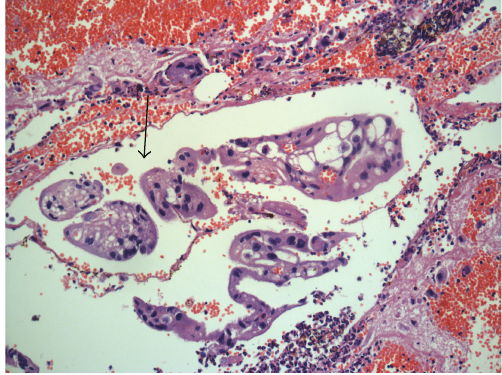
Figure 2: Trophoblast in hemorrhagic stroma. H&E × 100.